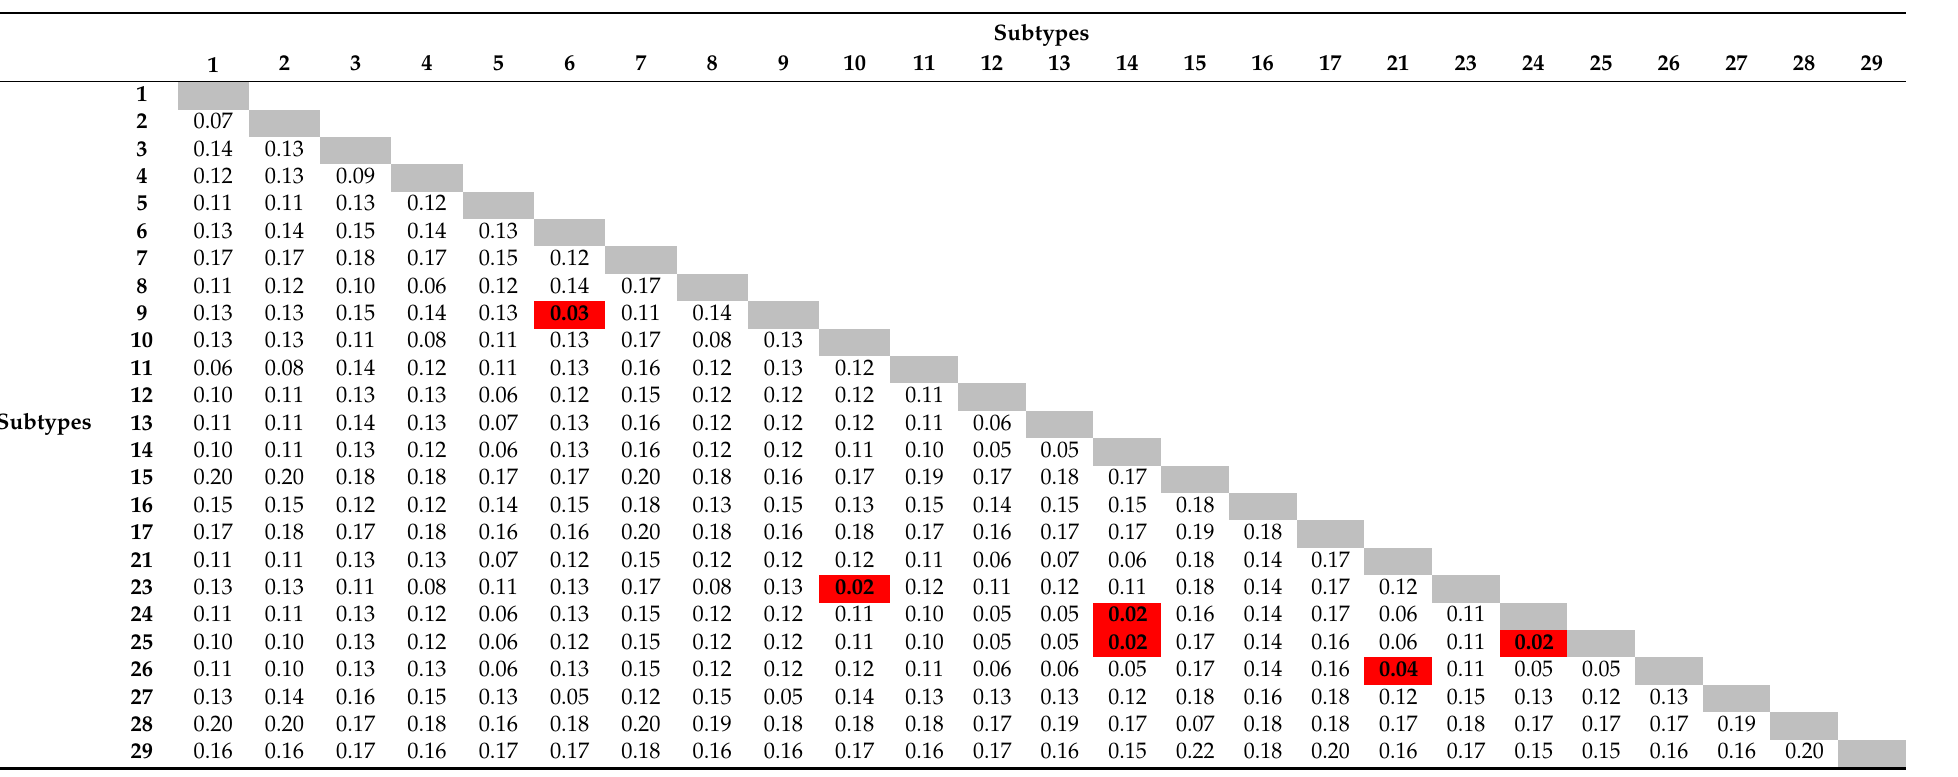
Table 3. Pairwise distances between Blastocystis subtypes full-length SSU rRNA gene sequences showing the average number of base substitutions per site. Analyses were conducted using the Kimura 2-parameter model and included 64 nucleotide sequences (Table 2). There were a total of 1953 positions in the final dataset. Red background indicates pairwise distance lower than